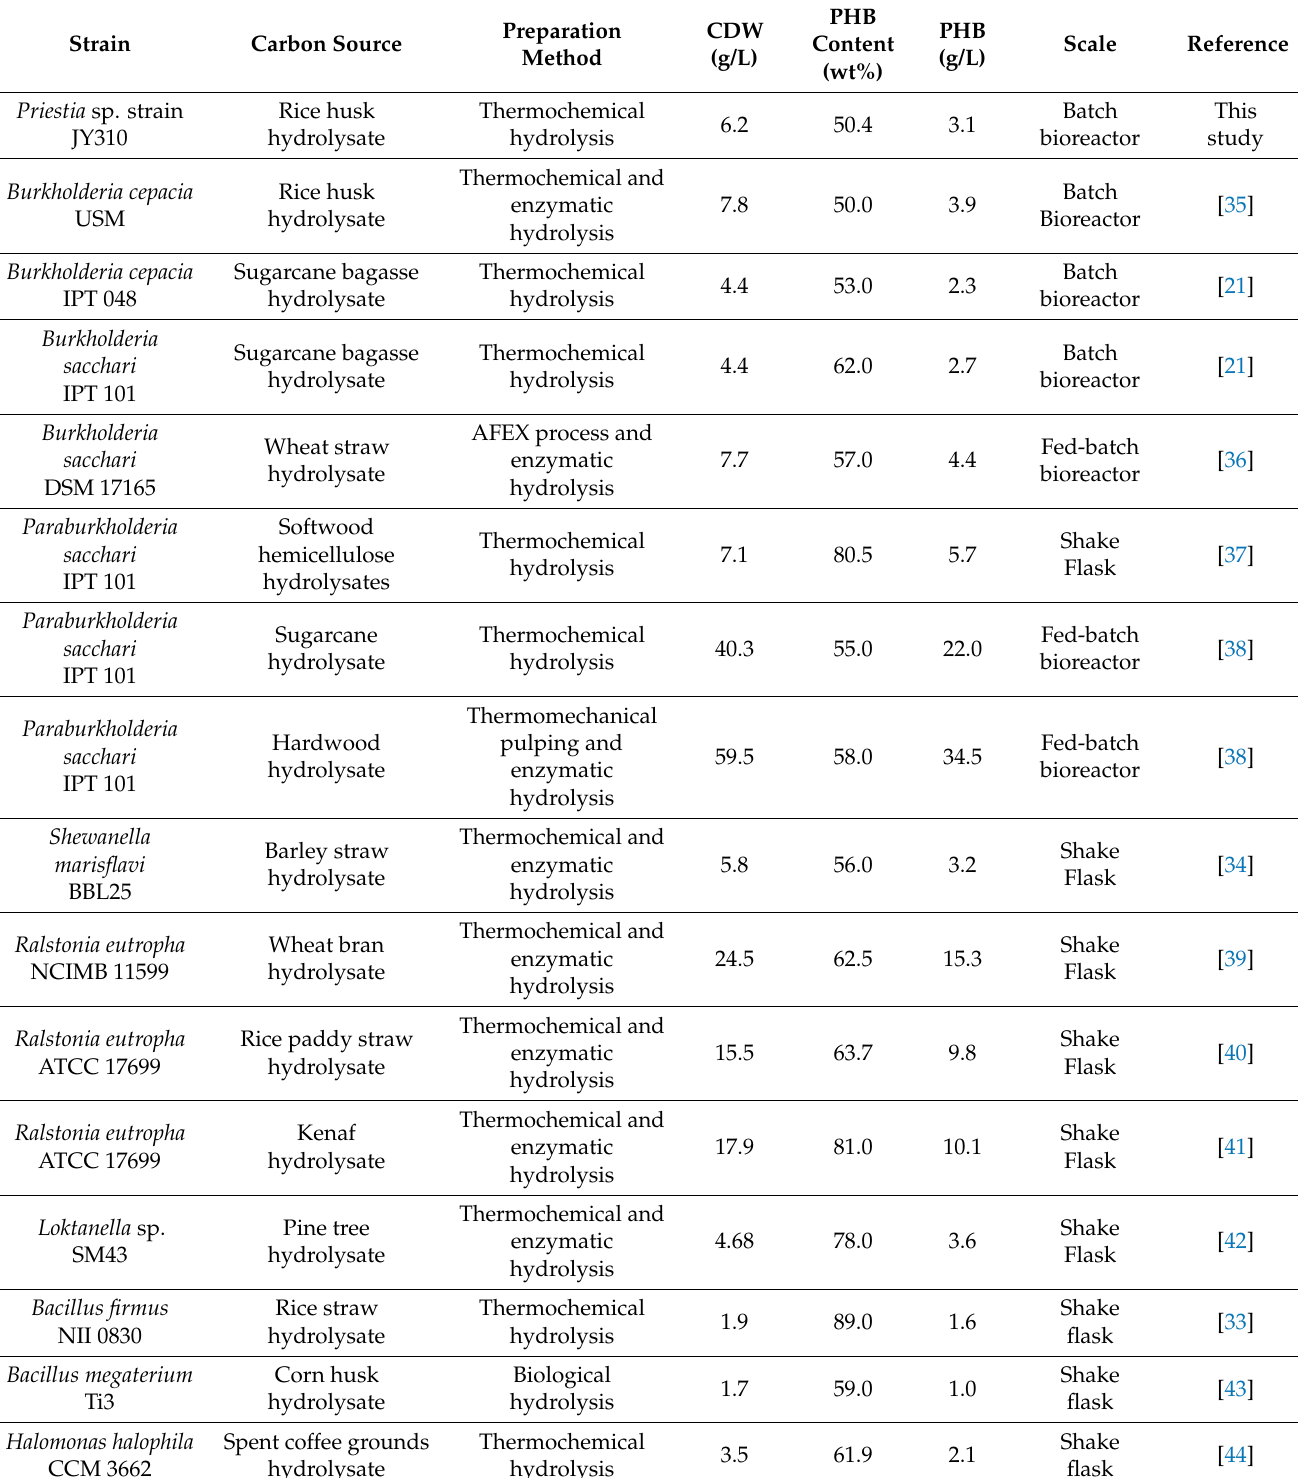
Table 1. Production of PHB by Priestia sp. strain JY310 and other bacterial species from lignocellulose